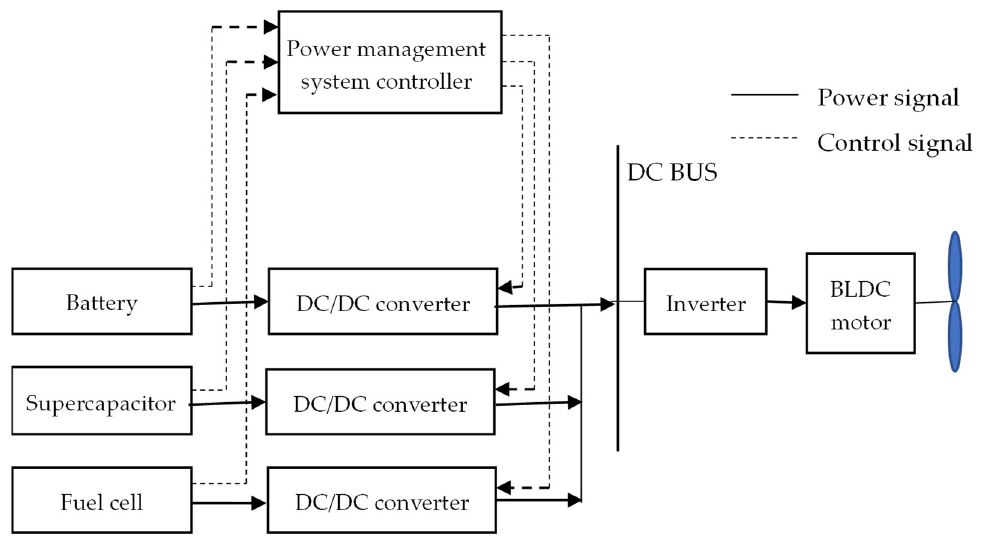
Figure 8. An architecture of an electric propulsion system on the hybrid system [34].